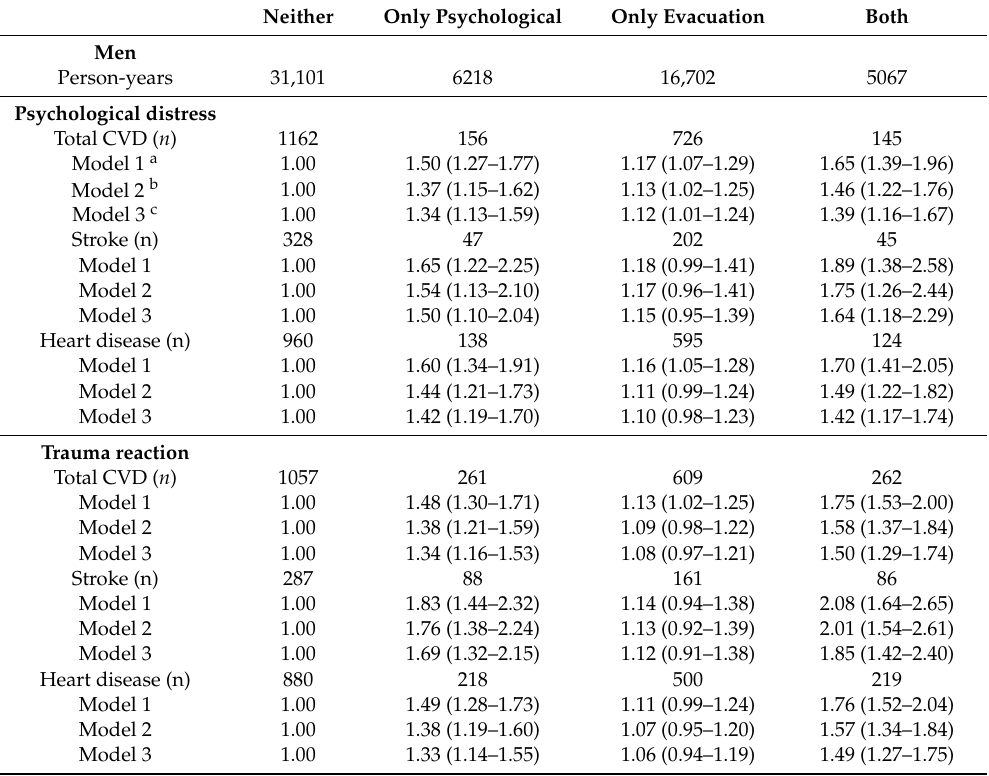
Table 3. Gender-specific age-adjusted and multivariable HRs (95% CIs) of CVDs according to the combination of psychological factors and evacuation